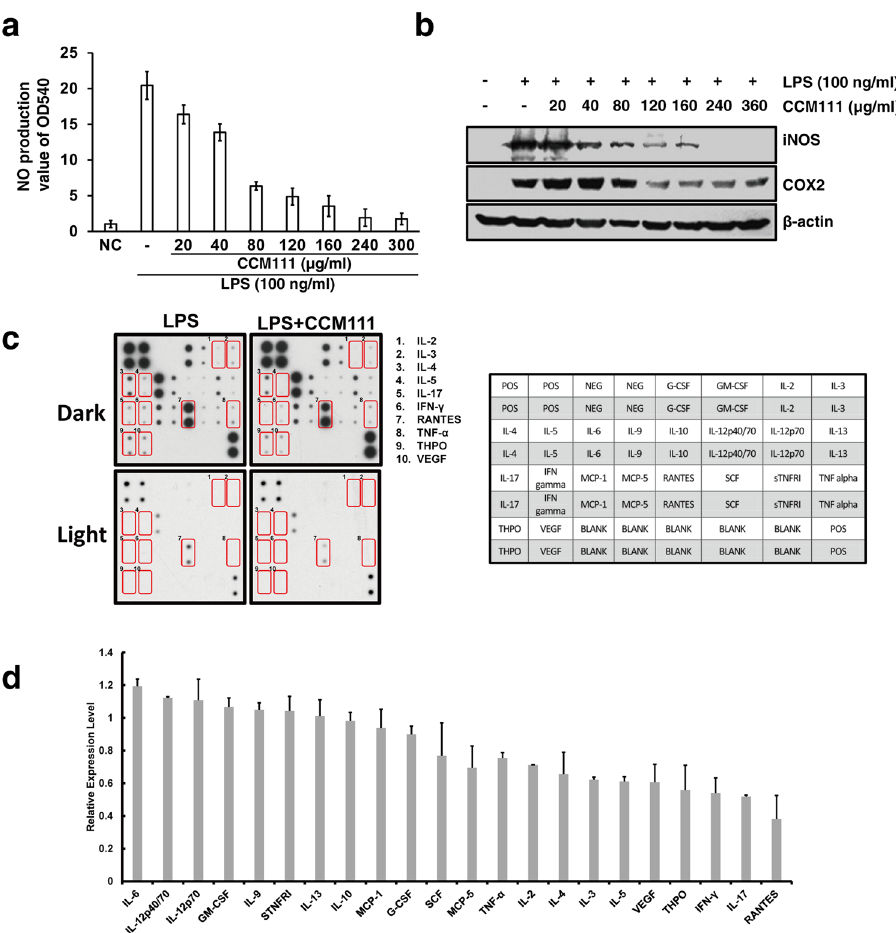
Figure 6. The effects of CCM111 on NO production and the protein expression of iNOS, COX-2, and inflammatory cytokines in murine RAW264.7 macrophages. The cells were treated with LPS (100 ng/ml) alone or in combination with different concentrations of CCM111. After incubation for 24 hours, the culture media was collected for nitrate assay analysis as shown in ( a ), and the protein lysates were analyzed by immunoblotting for iNOS, COX2 and β -actin as shown in ( b ) The full length blots images are presented in Supplementary Fig. 5a. Results in ( a ) and ( b ) were obtained from three independent replicates. The cells were treated with LPS (100 ng/ ml) alone or in combination with LPS and CCM111 (160 μ g/ml) for 24 h. The cell lysates were analyzed by the RayBio C-series mouse cytokine antibody array C1. ( c ) The left panel shows an image of the signal spots on the membrane for each cytokine. Each spot represents one cytokine, and each cytokine is in duplicate. Spots that show significant change are marked. The right panel shows the identities of all spots on the array with coordinates. The full length blots images are presented in Supplementary Fig. 5b. The left image of spots was scanned and measured by NIH Image-J software. ( d ) The relative expression level of each protein was calculated from densitometry data from ( c ) and normalized to the LPS treatment alone array. The blue dotted line represents a 0.8-fold difference, and the red dotted line represents a 1.2-fold difference. Error bars indicate S.D. (n =